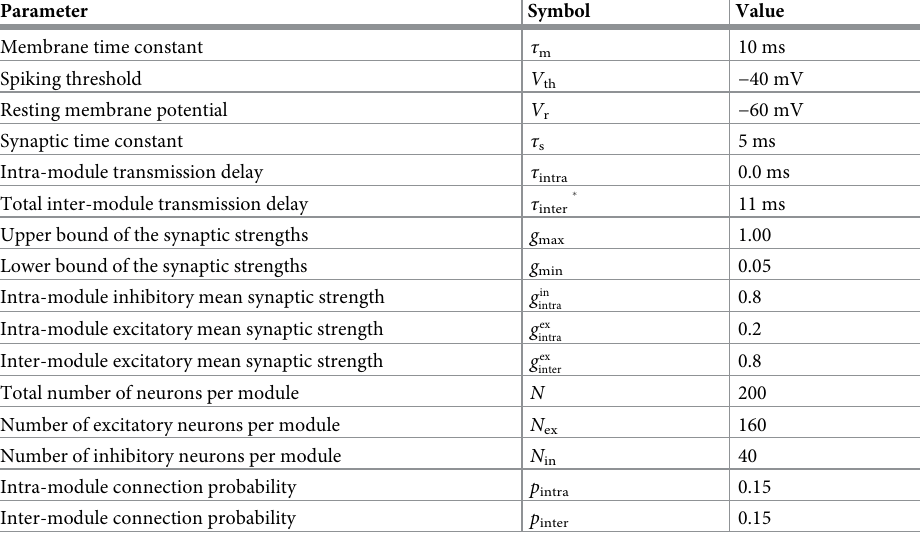
Table 1. Neuronal, synaptic and network model parameters